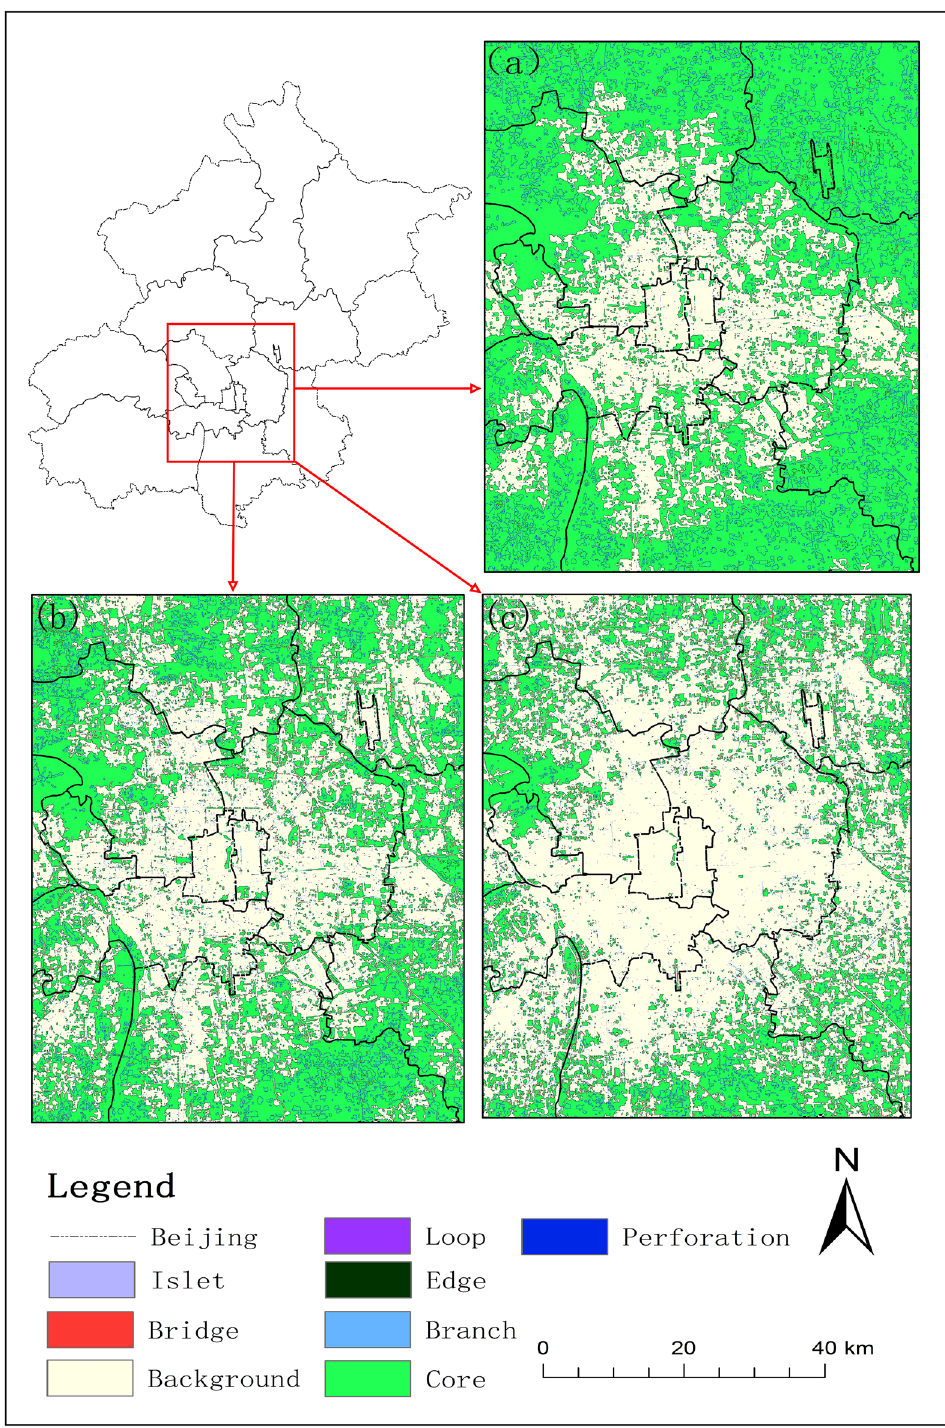
Figure 3. Distribution of UGI in 2030 in Beijing ( a ) ecological conservation priority scenario; ( b ) natural development scenario; ( c ) economic development priority scenario. The figure was drawn with ArcGIS sofware version 10.4. (https:// www. esri. com/ en- us/ arcgis/ produ cts/ arcgis- deskt op/ overv